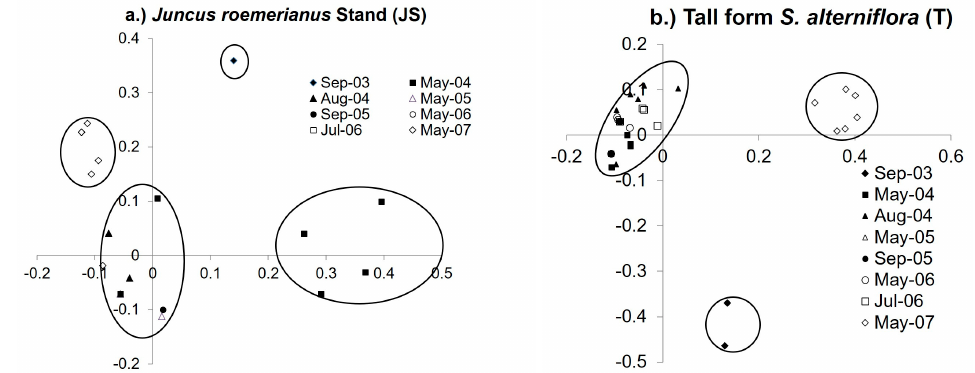
Figure 4. PCA results of ( a ) high marsh Juncus roemerianus (JS) and ( b ) low marsh tall form Spartina alterniflora (T) for all dates. Circles denote significance ( p < 0.001) for clustering. For JS Axis 1 represents 27.5% of the variance and Axis 2 represents 50.8% of the variance. For T Axis 1 represents 38.3% of the variance and Axis 2 represents 54.1% of the variance.